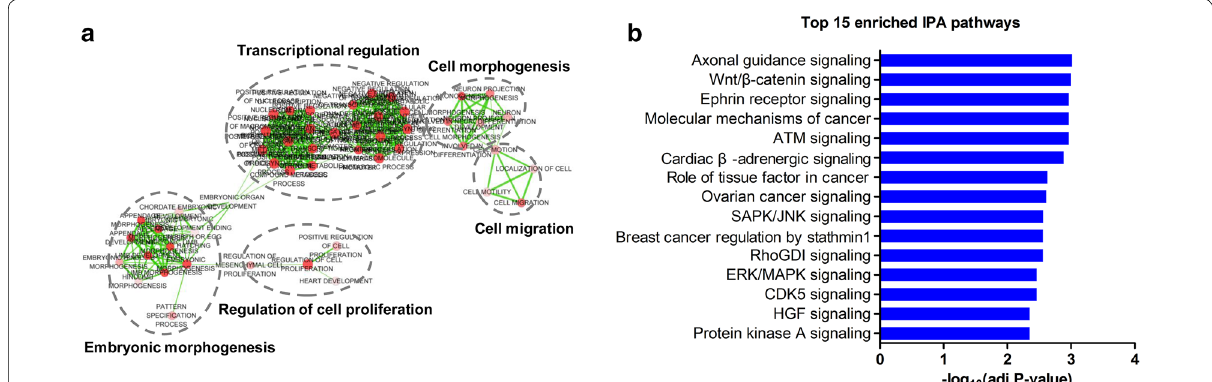
Fig. 4 Gene ontology (GO) and pathway enrichment analyses of target genes of the identified miRNA biomarkers. a Clusters of miRNA biomarker target-enriched GO terms at the biological process level. In the functional enrichment map, each node refers to a GO term and is grouped based on GO similarity; each edge represents there were shared genes between two connecting GO terms. Node size is determined by the gene number in each GO term. Node color intensity represents enrichment significance. Edge thickness is determined by the number of shared genes between two